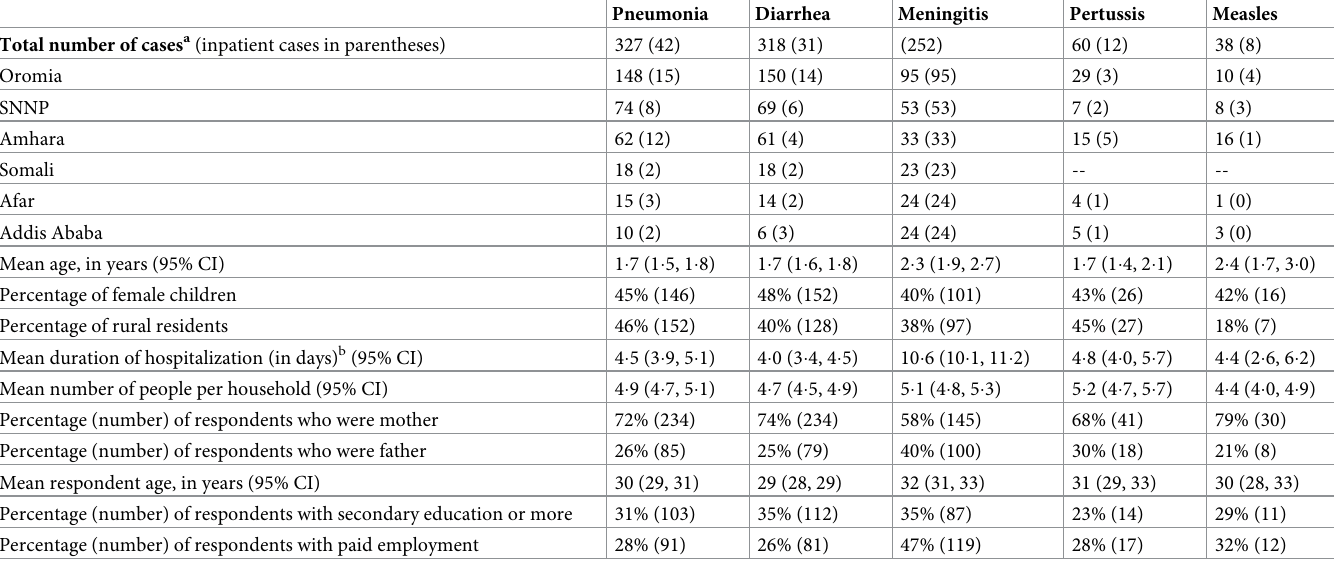
Table 1. Summary characteristics of the study sample, by type of disease episode.